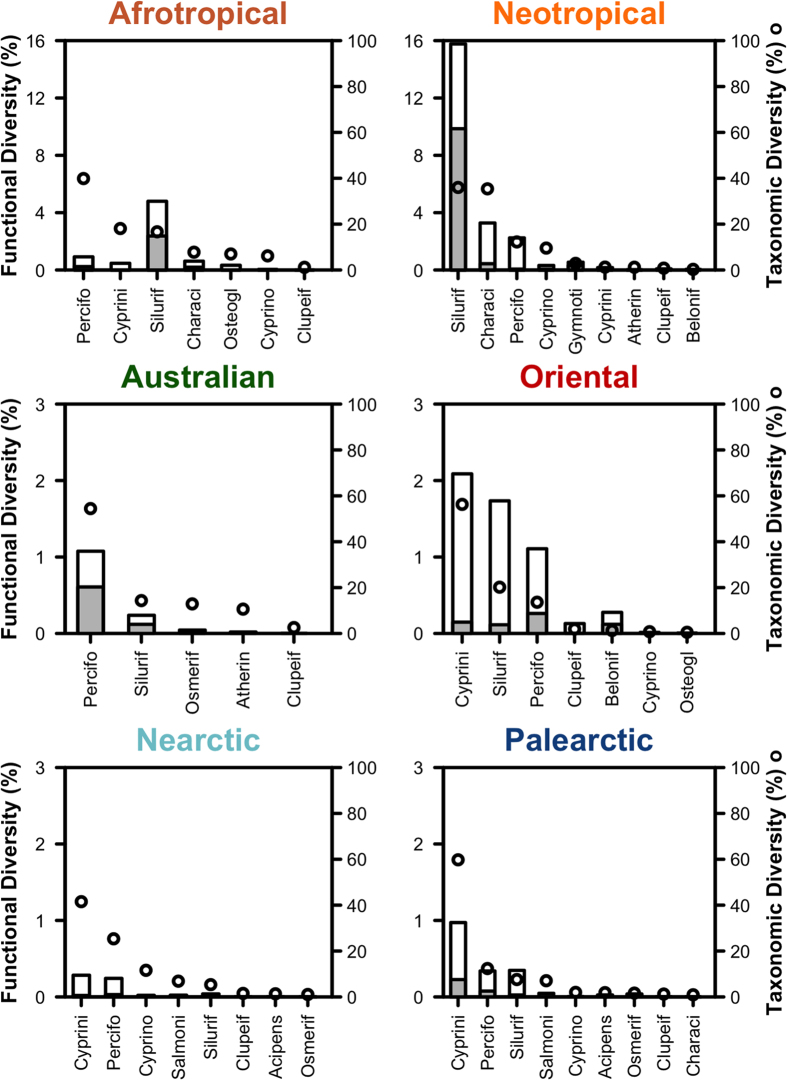
Functional diversity and uniqueness of fish orders within realms.The functional diversity (FD) of each fish order in each realm is given as the percentage of the world FD (bars). The part of FD of each order non-filled by any other order in the realm (Functional uniqueness, Funiq) is the ratio between the grey part and the FD of each order. Note that the FD scale differs between realms. The orders are sorted by decreasing TD in each realm and the black dots indicate the percentage of the realm TD represented by each order. Only the 13 most speciose orders in the world are represented (Acipens: Acipenseriforms; Atheri: Atheriforms; Belonif: Beloniforms; Characi: Characiforms; Clupei: Clupeiforms; Cyprini: Cypriniforms; Cyprino: Cyprinodontiforms; Gymnoti: Gymnotiforms; Osteogl: Osteoglossiforms; Osmerif: Osmeriforms; Percifo: Perciforms; Salmoni: Salmoniforms; Silurif: Siluriforms).